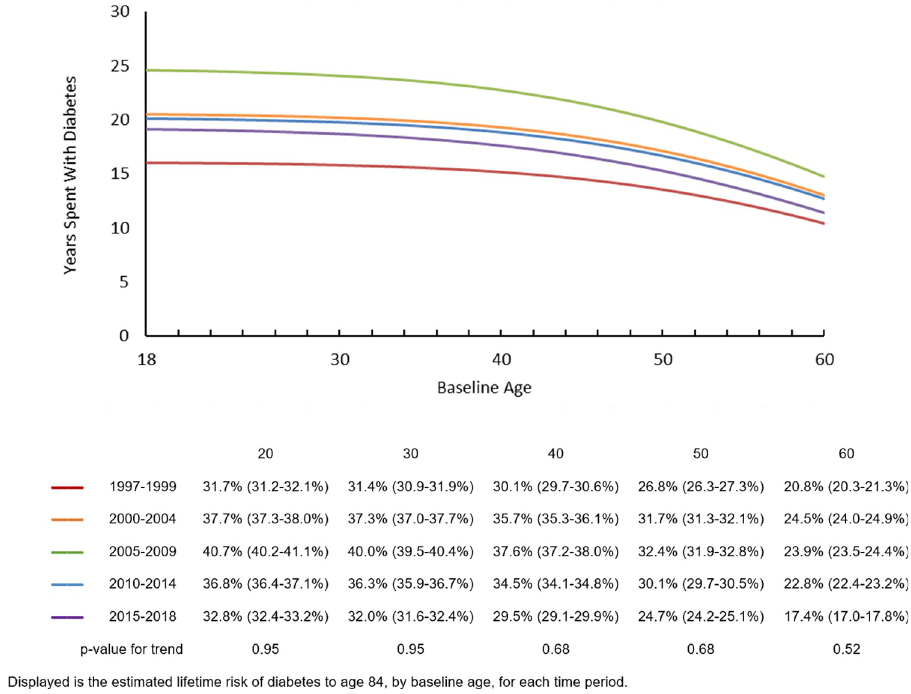
Fig 3. Years spent with diabetes, by baseline age and time